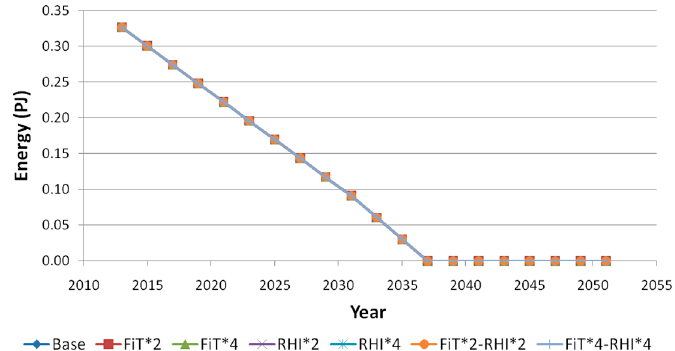
Figure 12. Less-favourable area farms (LFA) farms—fuel consumption.